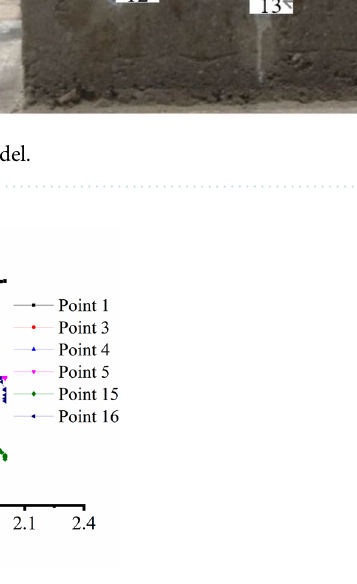
Figure 7. Tangential strain variation vs. vertical load at each measuring spot around the tunnel during loading.